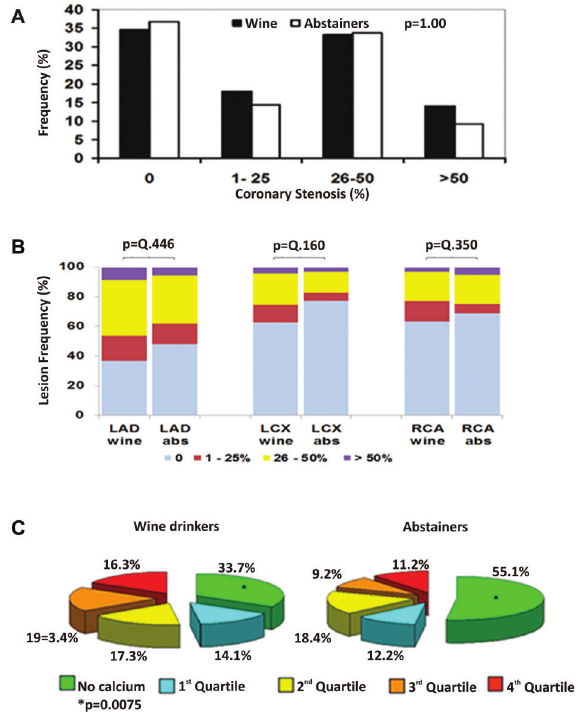
Figure 1. A , Frequency of coronary lesions/patient, classified as absent (0 stenosis), 1-25, 26-49, and > 50%, encompassing 16 segments/patient, in red wine (RW) drinkers and abstainers (Abs). No significant differences were found. B , Frequency of coronary lesions in LAD, LCX and RCA territories (0; blue), 1-25% (green), 1-49% (yellow), and > 50% stenosis (red). Sixteen coronary segments were analyzed in each individual by computed coronary angiography. There were no significant differences between the groups, except for 0 lesions in LCX, which were more frequent among abstainers. LAD: left anterior descending artery; LCX: left circumflex coronaryartery; RCA: right coronary artery. C , Quartiles of age-adjusted coronary calcium score in wine drinkers and abstainers. Total calcium score was significantly greater in RW drinkers compared to abstainers (144.4±362.2 vs 122.0±370.3 Agatston units, respectively; chi-square test, P , 0.001). Significantly greater percentage of individuals with no calcium was observed among abstainers (in green). Table 2. Arterial reactivity and carotid study.